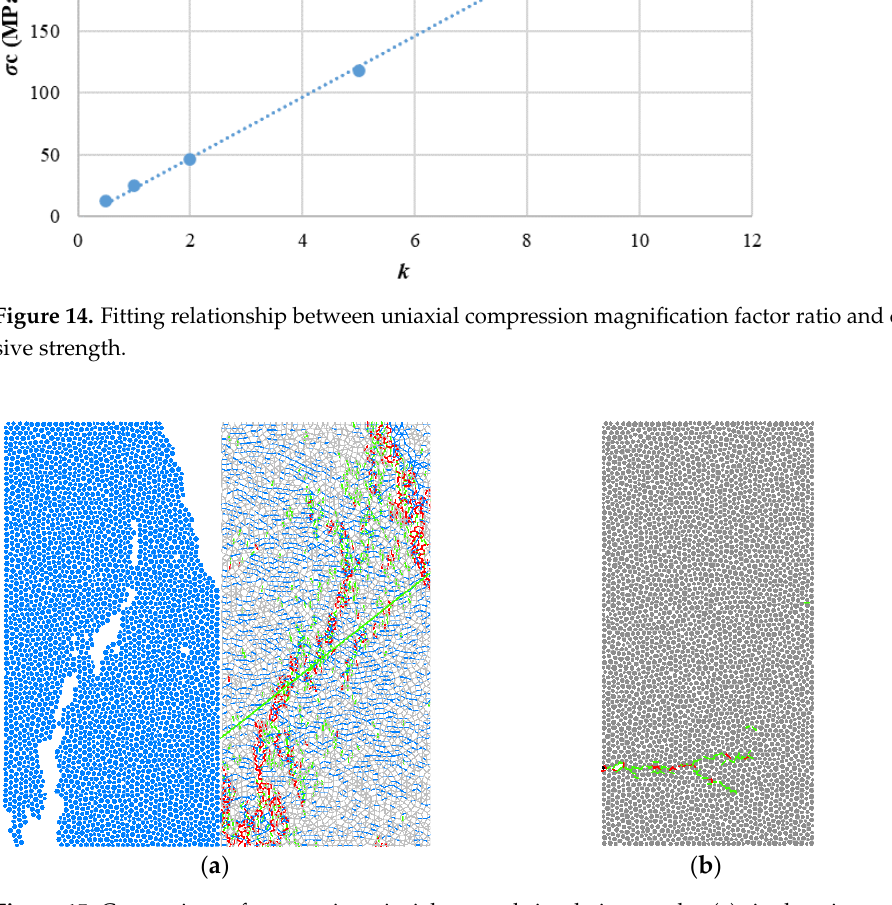
Figure 15. Comparison of rupture in uniaxial test and simulation results, ( a ) single-axis compression simulation, ( b ) uniaxial tensile simulation. (As shown in the figure above, colored lines are cracks, and gray and white particles).